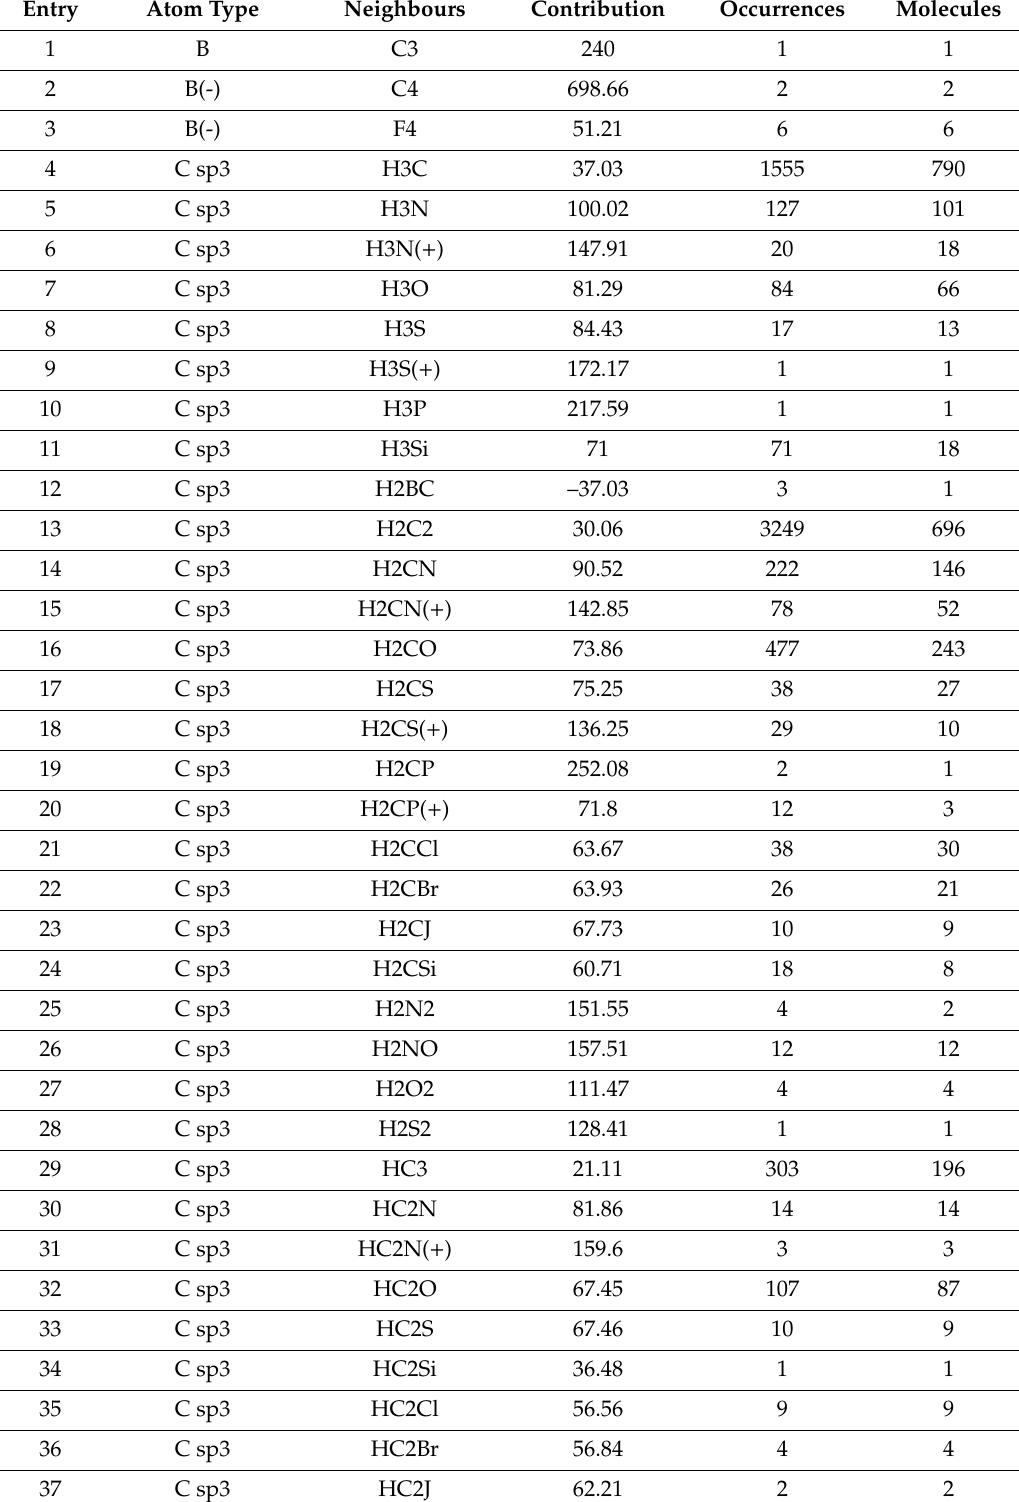
Table 3. Atom groups and their contributions for the heat-capacity calculation of